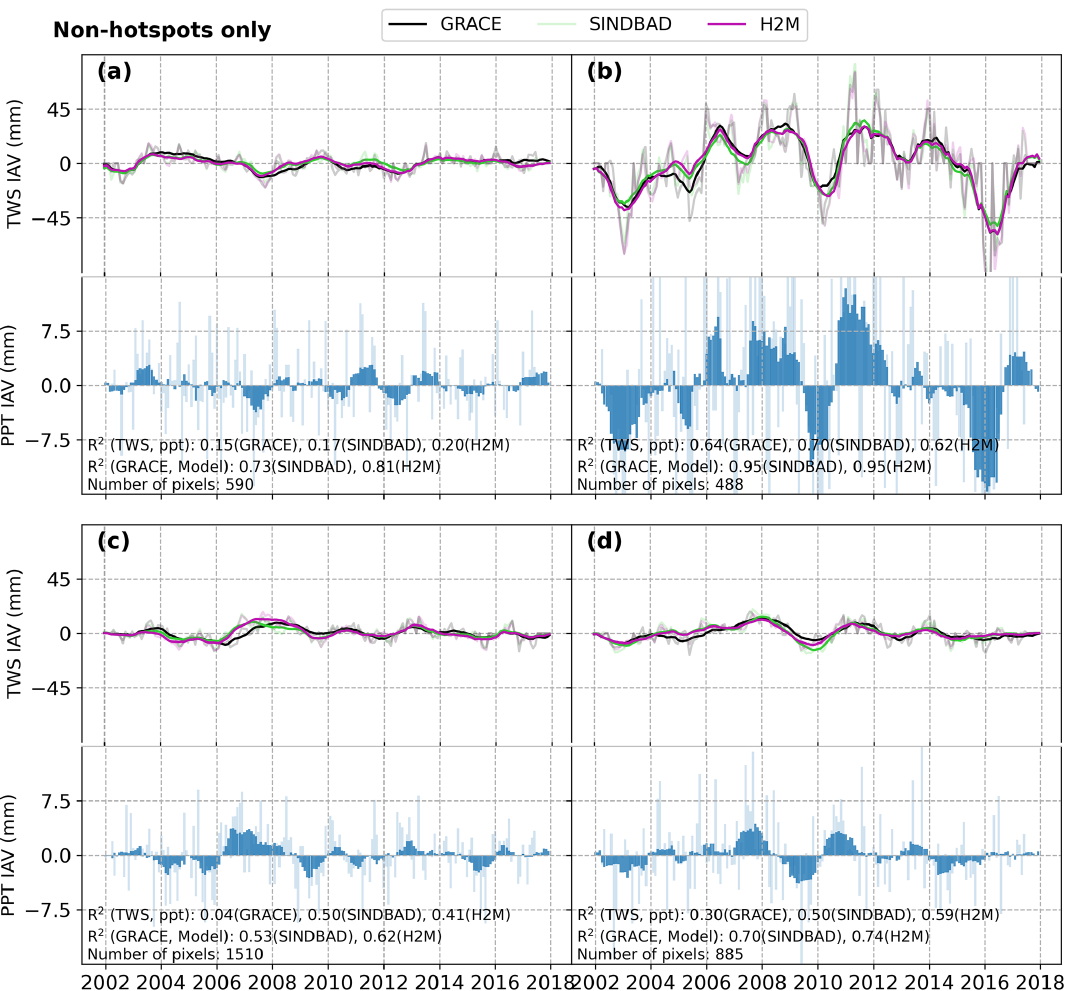
Figure B6. Same as Fig. 6 but using non-hotspot pixels.